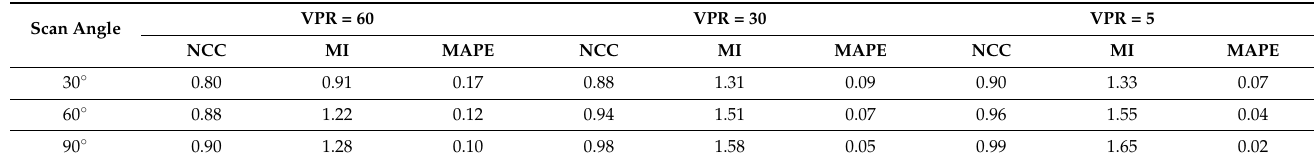
Table 2. The accuracy of the reconstructed target